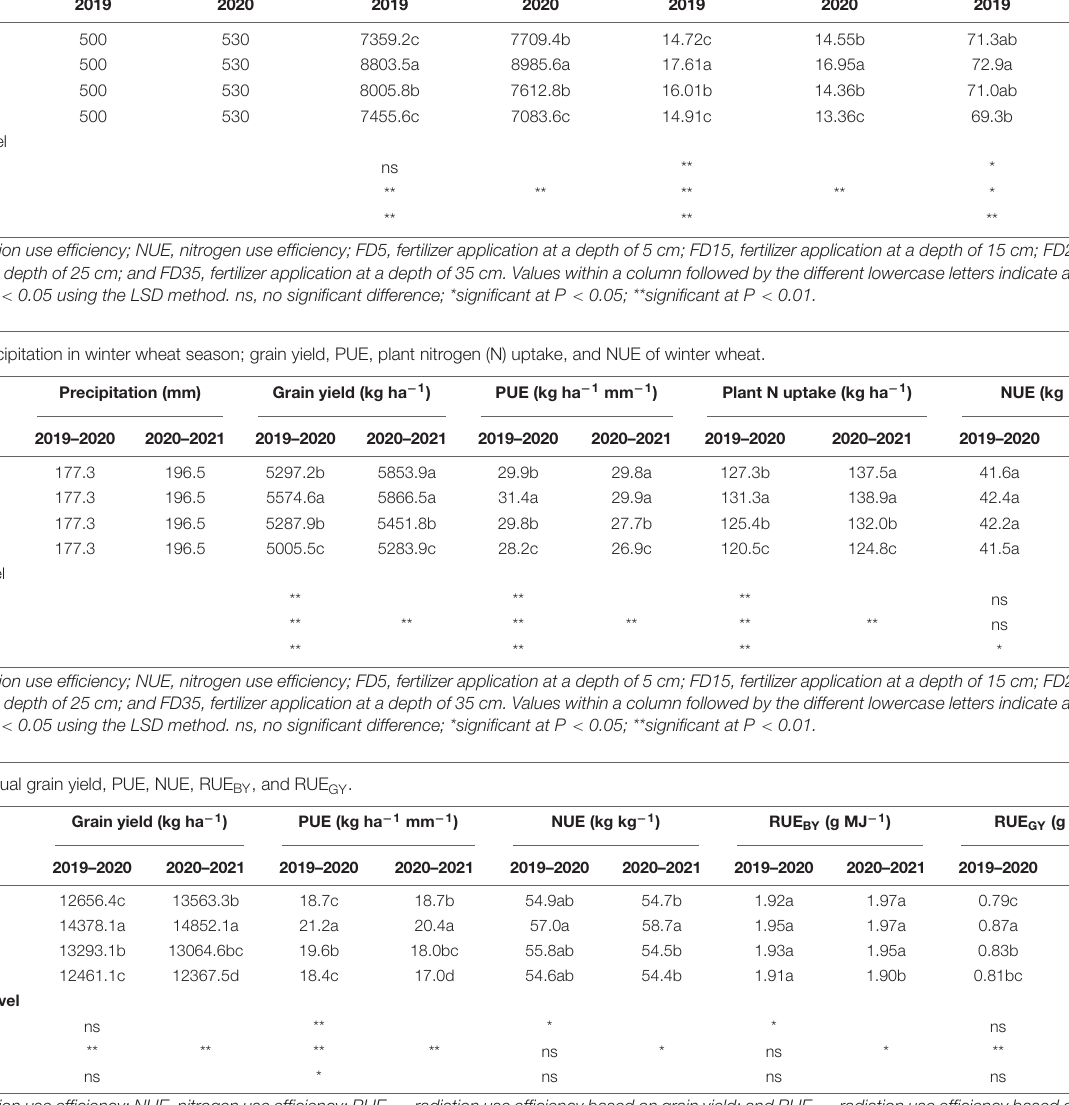
TABLE 1 | Precipitation in summer maize season; grain yield, PUE and NUE of summer maize. Treatment Precipitation (mm)